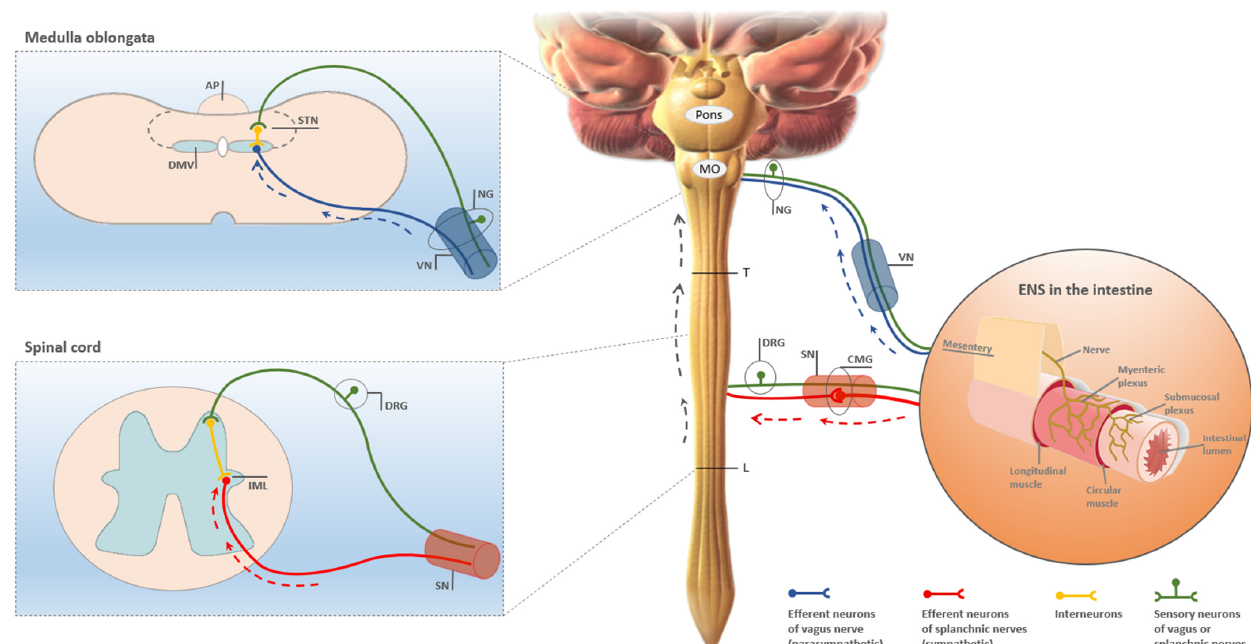
Figure 2. Pictorial representation of the neural gut–brain axis thought to be involved in the centripetal spread of pathological protein aggregation from the intestine to the CNS in both peroral prion infections as well as PD. As established in great detail for perorally acquired TSE early spread of prions and PrP TSE pathology to the CNS occurs from ENS ganglia in a retrograde direction along parasympathetic and sympathetic efferents of the vagus and splanchnic nerves, to the DMV in the medulla oblongata and the IML in the spinal cord, respectively (reviewed in: [46,48]). A similar concept was subsequently proposed for the propagation of LP in PD from enteric ganglia in the gastrointestinal tract to the CNS, initially with respect to parasympathetic and later also with respect to sympathetic spreading pathways [14,73,76]. Dashed blue and red arrows indicate retrograde spread via efferent parasympathetic or sympathetic projections of the vagus or splanchnic nerves, respectively, for both peroral prion infections and PD. Dashed grey arrows mark spinal ascension of PrP TSE pathology or LP to the brain following invasion of the IML at thoracic spinal cord levels of splanchnic innervation [46,73]. The figure was produced, with modifications, following templates from McBride et al. [32] and Mabbott and MacPherson [48]. Credits for mounted image components: “Blausen 0838 Sympathetic Innervation” and “Blausen 0703 Parasympathetic Innervation” by Bruce Blaus are licensed under the Creative Commons Attribution 3.0 Unported License (CC BY 3.0); “Anatomic structure of enteric plexus” (image ID FK8KPF) is licensed by Alamy Limited (Abingdon, UK, invoice number IY01945617). AP, area postrema; CMG, celiac or mesenteric ganglion; DMV, dorsal motor nucleus of the vagus nerve; DRG, dorsal root ganglion; ENS, enteric nervous system; IML, intermediolateral cell column; L, border between thoracic and lumbar spinal cord; MO, medulla oblongata; NG, nodose ganglion; SN, splanchnic nerves; STN, solitary tract nucleus; T, border between cervical and thoracic spinal cord; VN, vagus